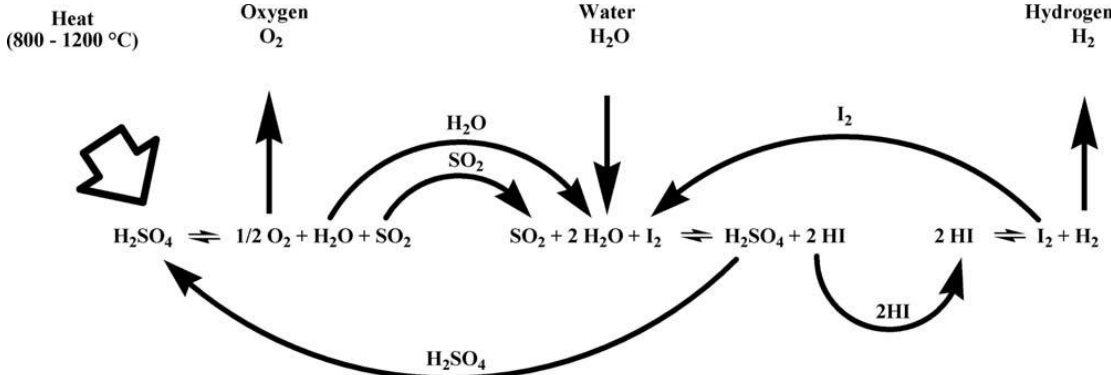
Figure 5. A sample process flow diagram of the S-I cycle [108].